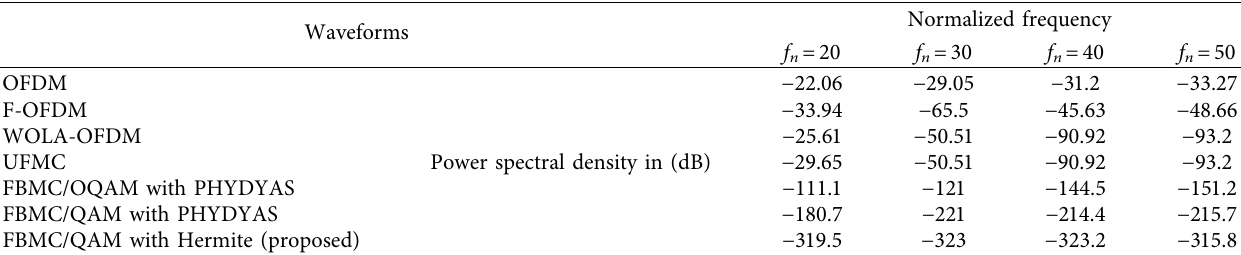
Figure 7: Power spectral density versus normalized frequency of diferent multicarrier modulation techniques for subcarrier spacing of 15kHz and number of subcarriers of 1024. Table 2: Power spectral density of diferent modulation schemes at 20, 30, 40, and 50 normalized